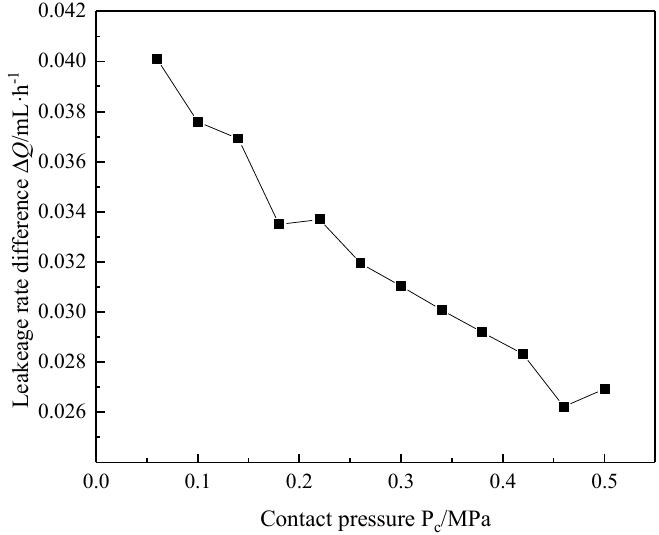
Figure 10. The influence of contact pressure on leakage rate ( Δ Q ).